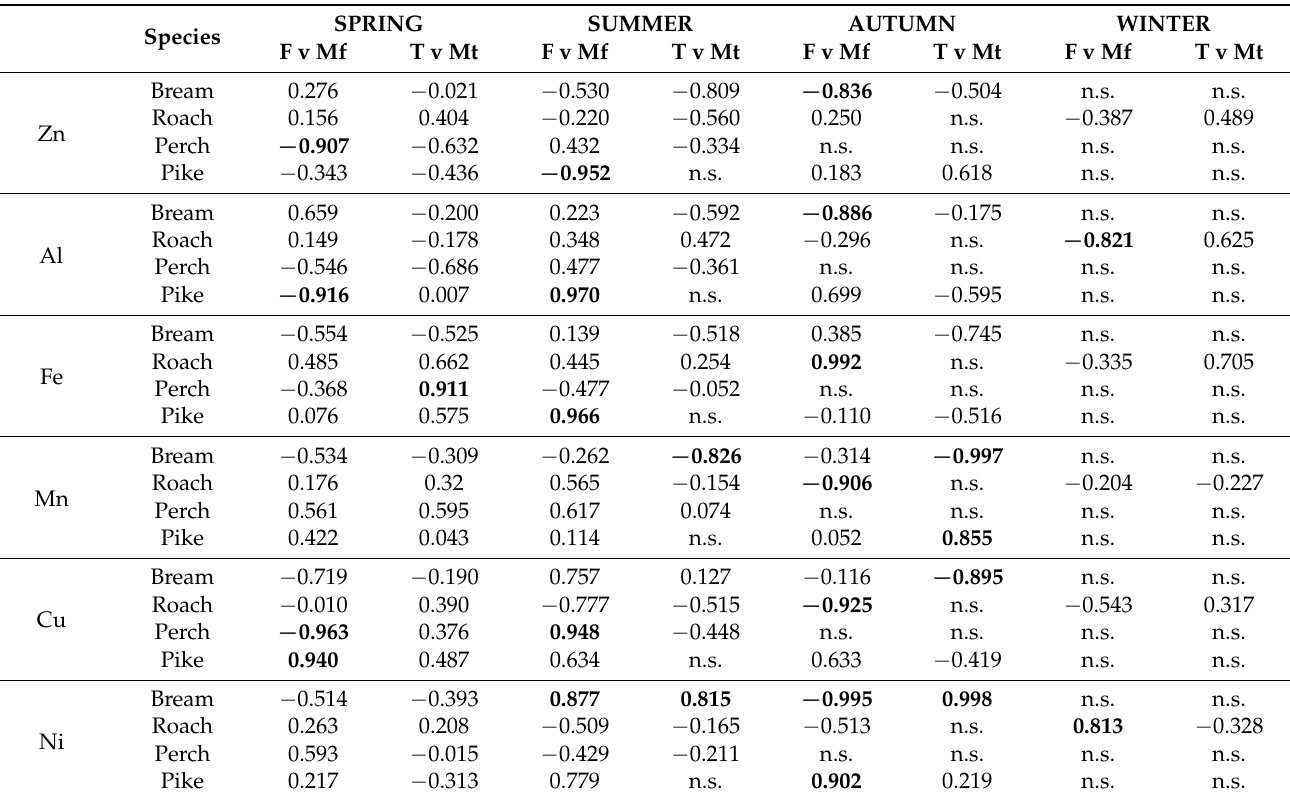
Table 5. Pearson’s correlation coefficients (r) between the content of minerals in fish gonads and muscles in the studied seasons ( p <